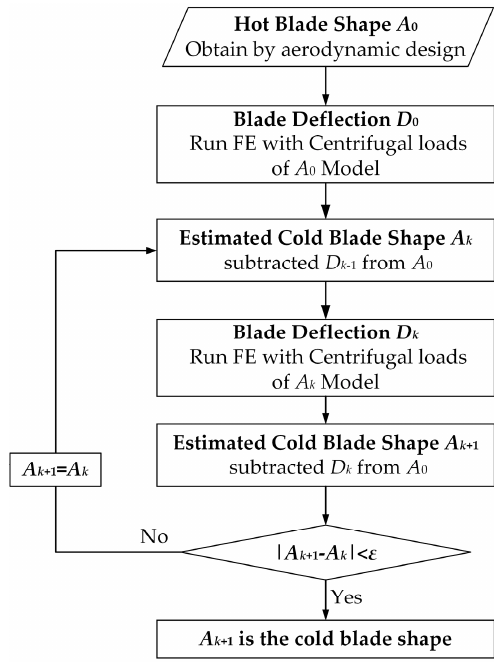
Figure 6. Flow chart of UCM method.